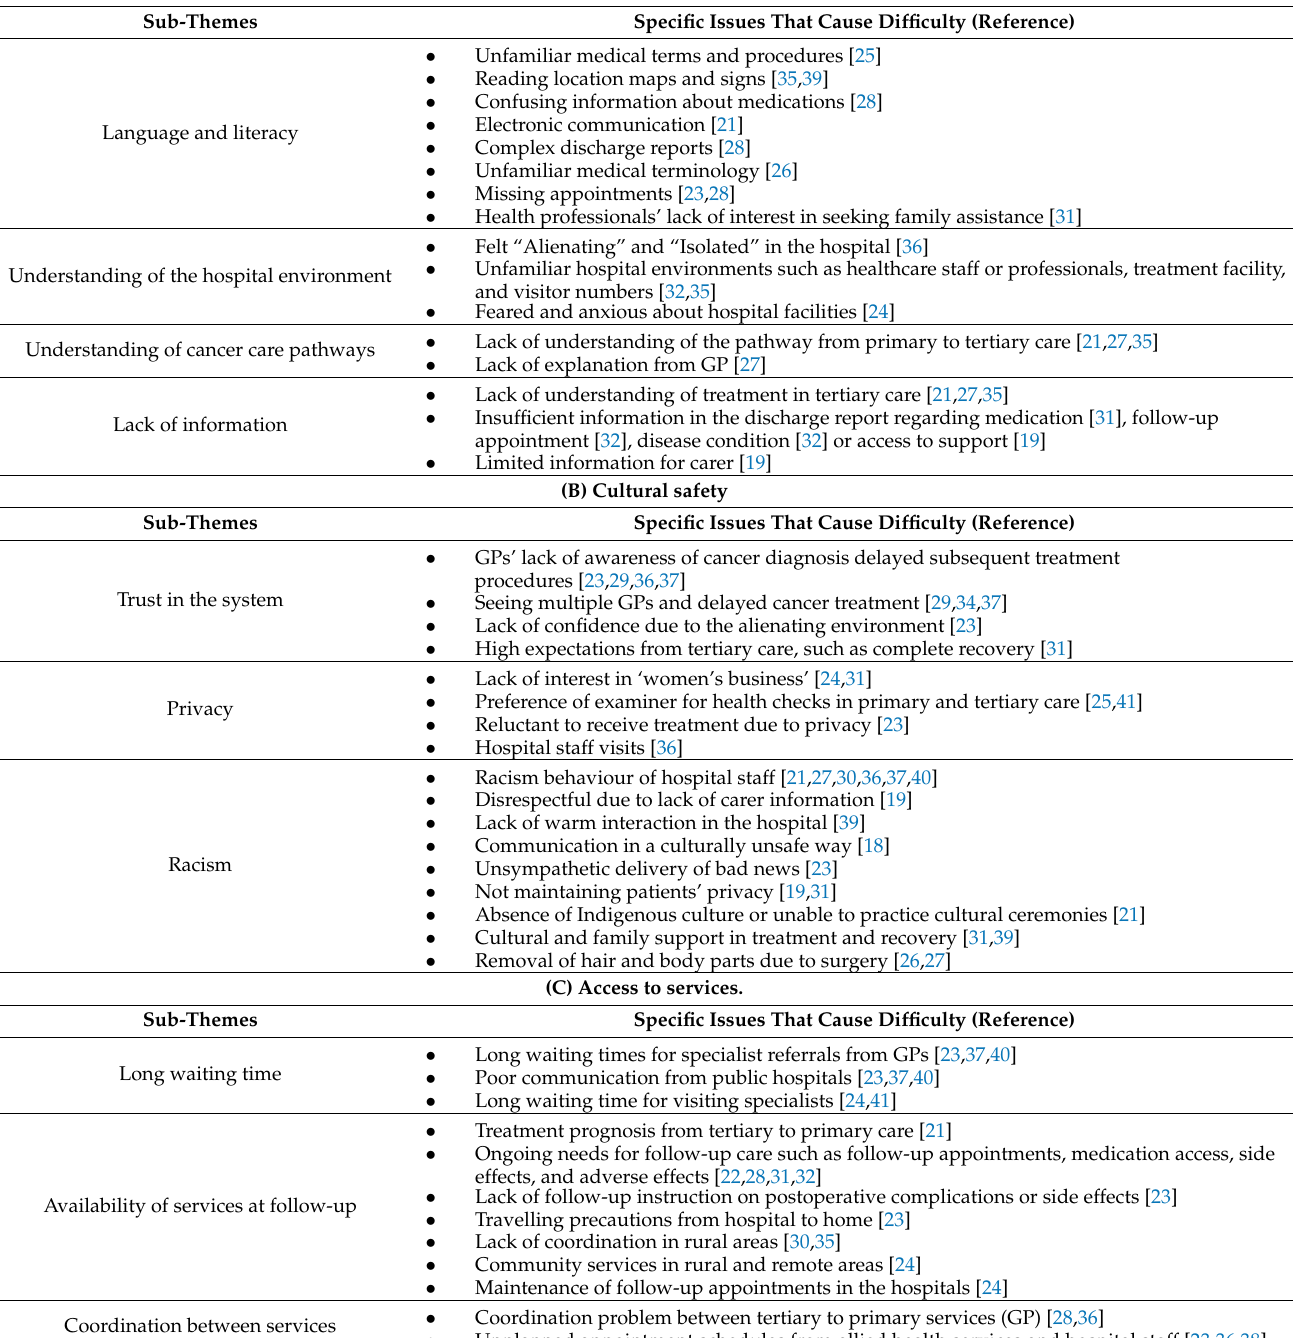
Table 2. Key themes and issues found in Indigenous peoples’ cancer care